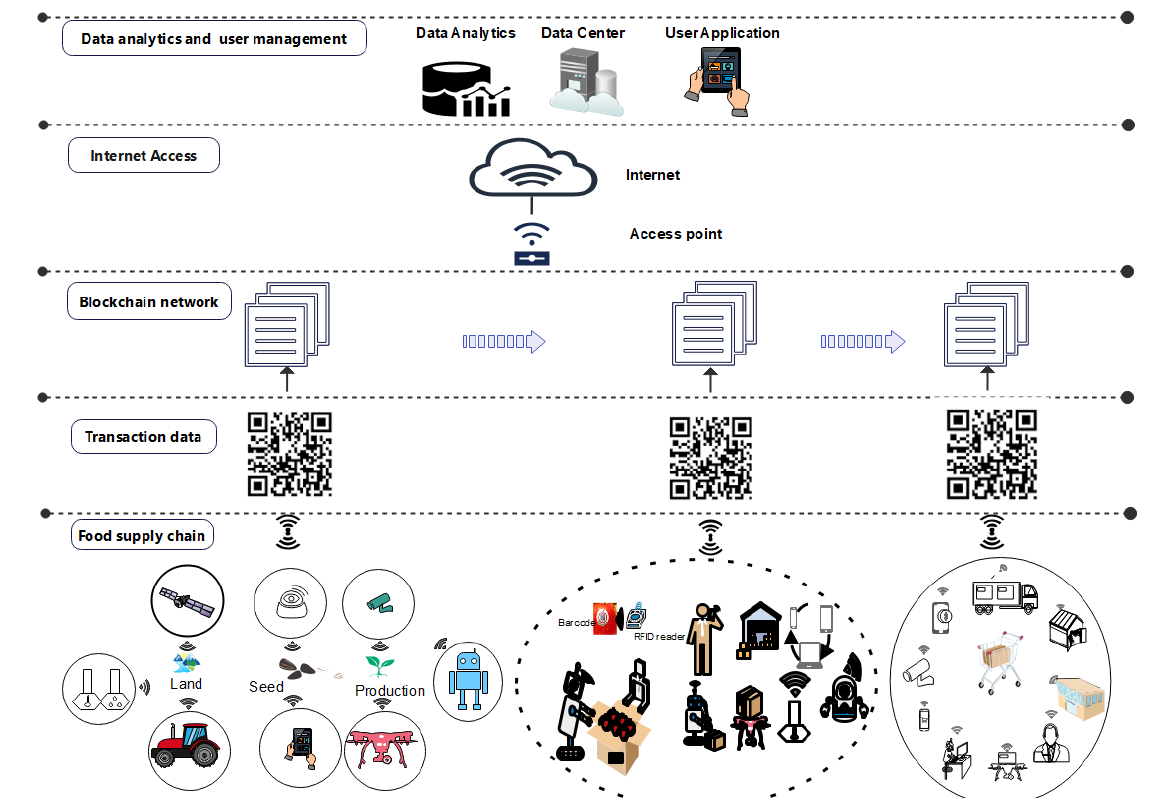
Figure 8. Blockchain in food supply chain.